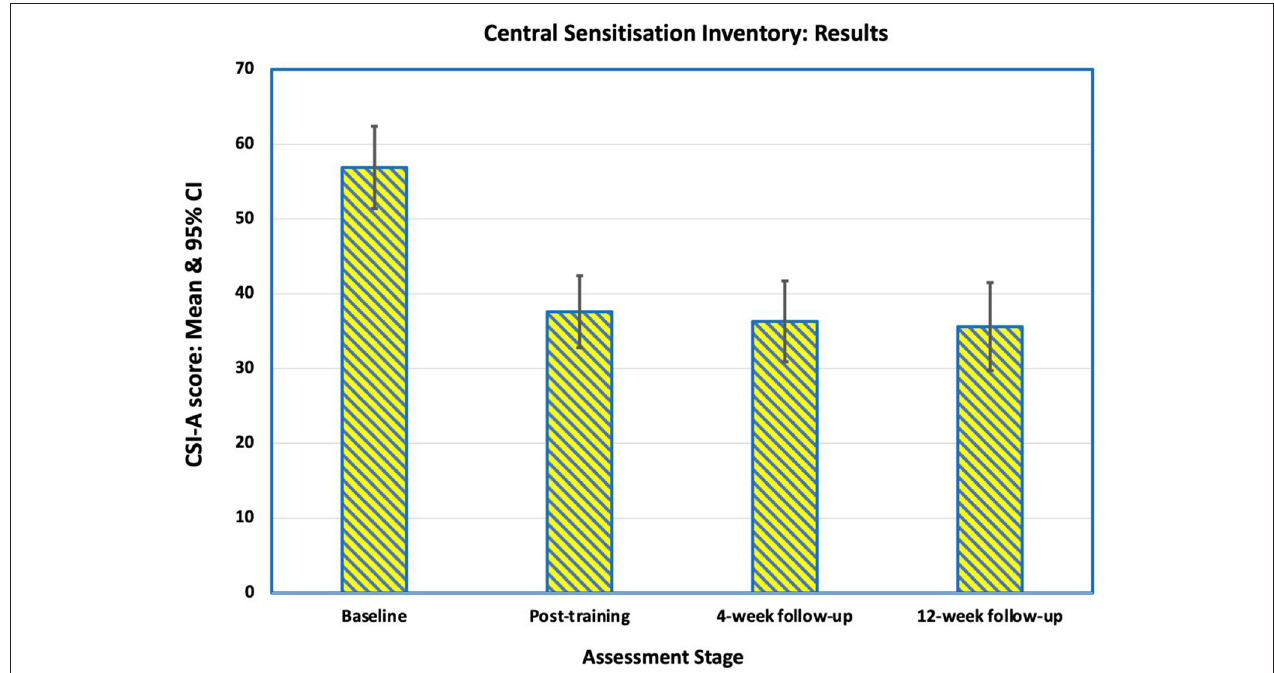
FIGURE 4 | Mean scores on the Central Sensitization Inventory Part A (CSI-A) for the 16 participants at baseline, immediately after training, at 4-week follow-up and at 12-week follow-up . The reduction in mean score indicates an improvement in self-reported symptoms of central sensitization pain.